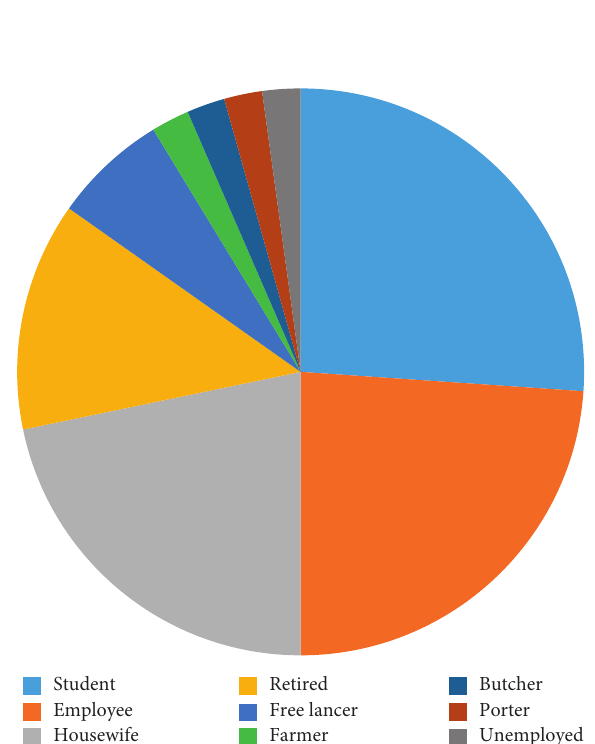
Figure 1: Distribution of psoriatic patients with fungal infections according to their occupation: student ( n � 12), employee ( n � 11),